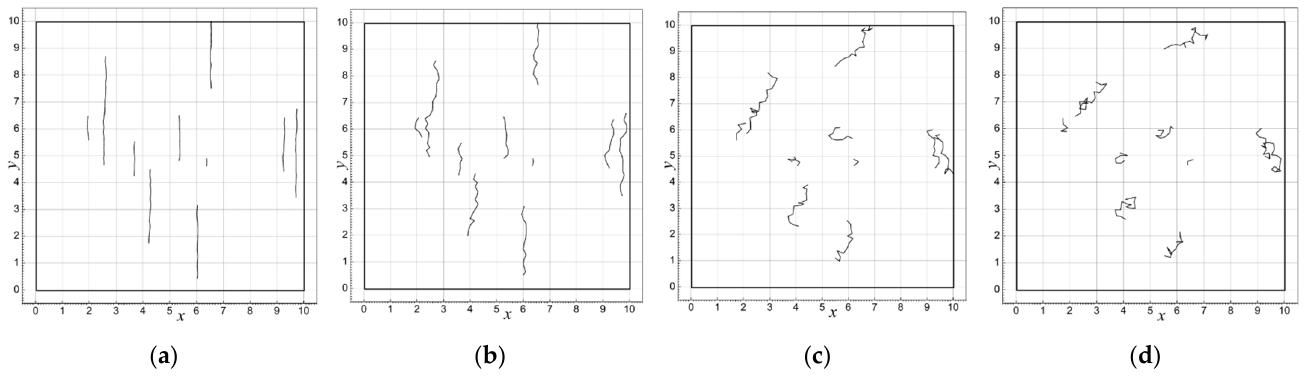
Figure 3. Examples of generated linear defects according to the described procedure after ten iterative steps, for α 0 = 90° and different parameter values σ α : ( a ) 5°, ( b ) 25°, ( c ) 45°, and ( d ) 90° .